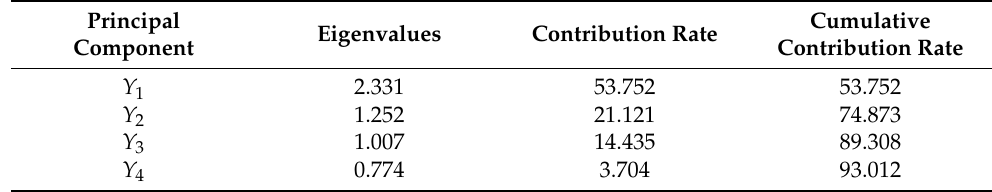
Table 1. The SPSS analysis